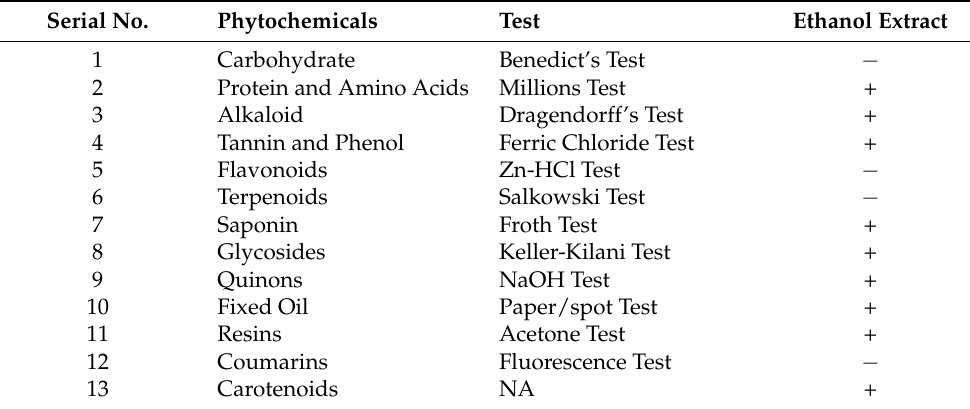
Table 1. Qualitative phytochemical screening of Martynia annua ethanol extract. Serial